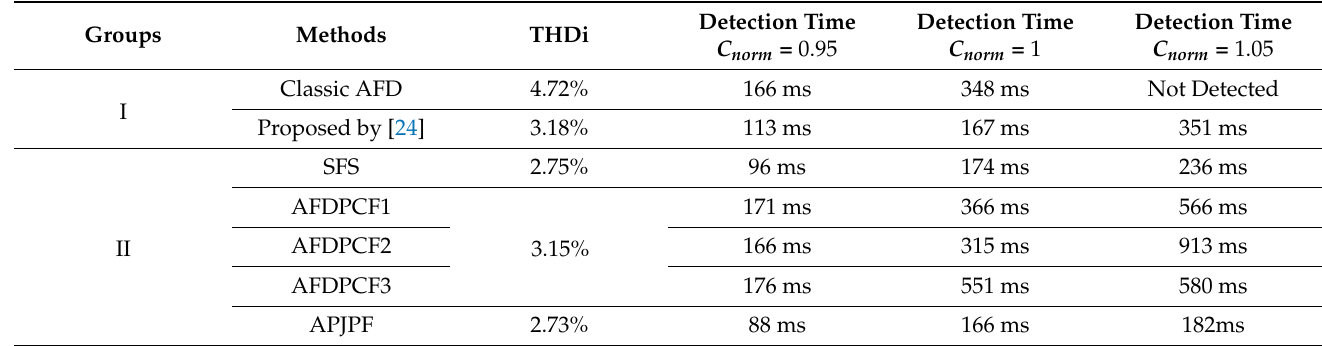
Table 3. Synthesis of the main performance indicators of the analyzed AIP methods.